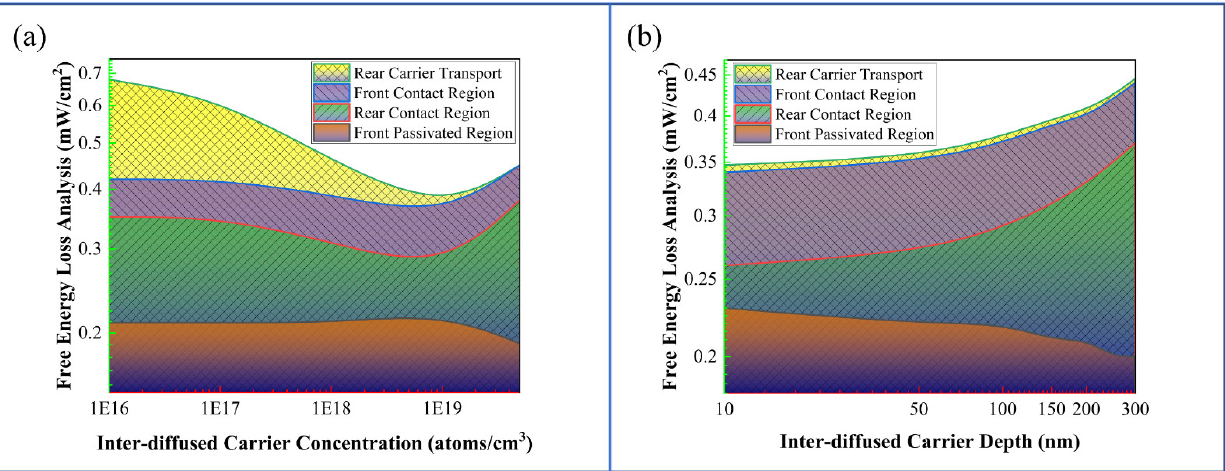
Figure 15. Free energy loss analysis (FELA) by applying the TCAD assessment tool [104].